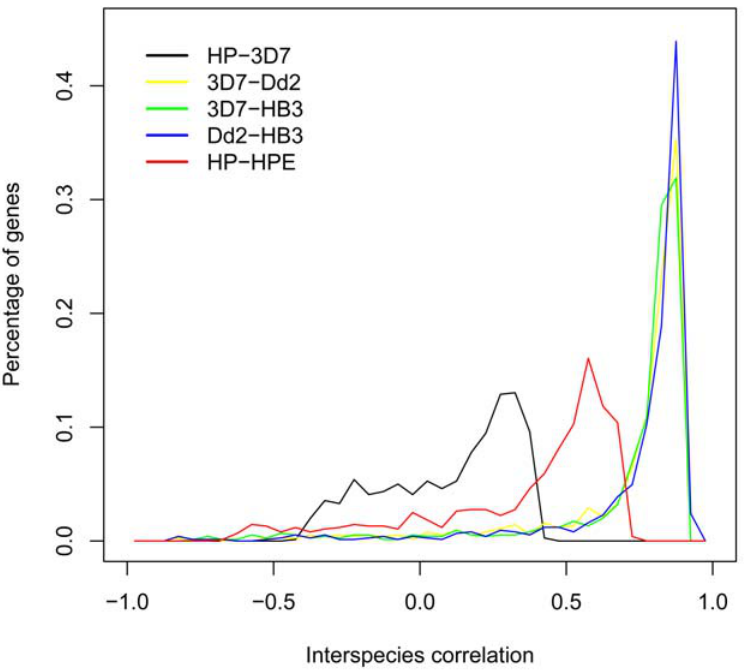
Figure 7. Interspecies correlations show a greater percentage of diverged genes than intraspecies correlations. There are significantly more diverged genes in the interspecies comparison (black: P. falciparum 3D7 strain vs P. berghei HP strain) than in the intraspecies comparisons (yellow: P. falciparum 3D7 strain vs P. falciparum Dd2 strain; green: P. falciparum 3D7 strain vs P. falciparum HB3 strain; blue: P. falciparum Dd2 strain vs P. falciparum HB3 strain; red: P. berghei HP strain vs P. berghei HPE strain).